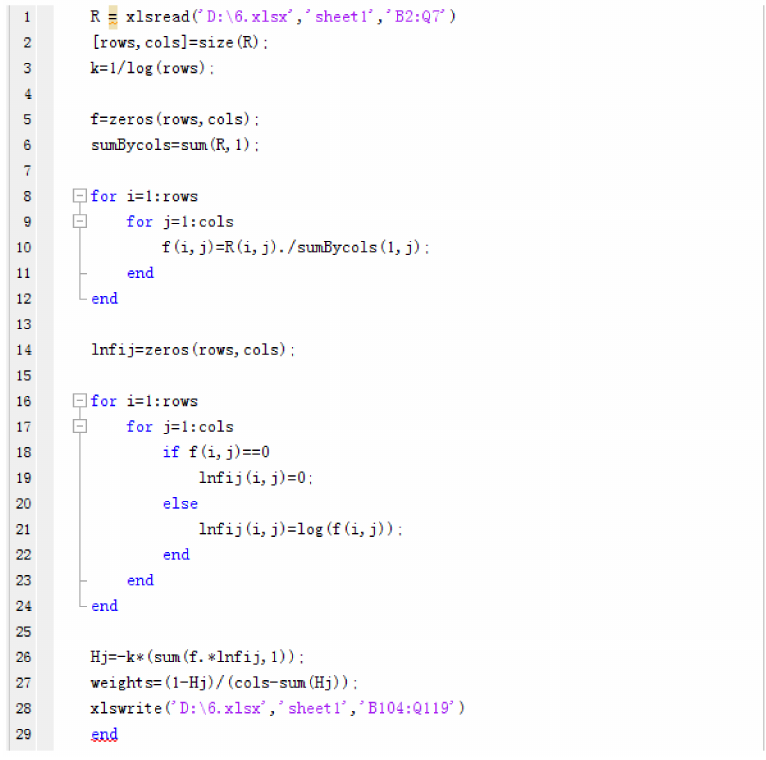
Figure A3. Applying MATLAB to obtain objective weights of